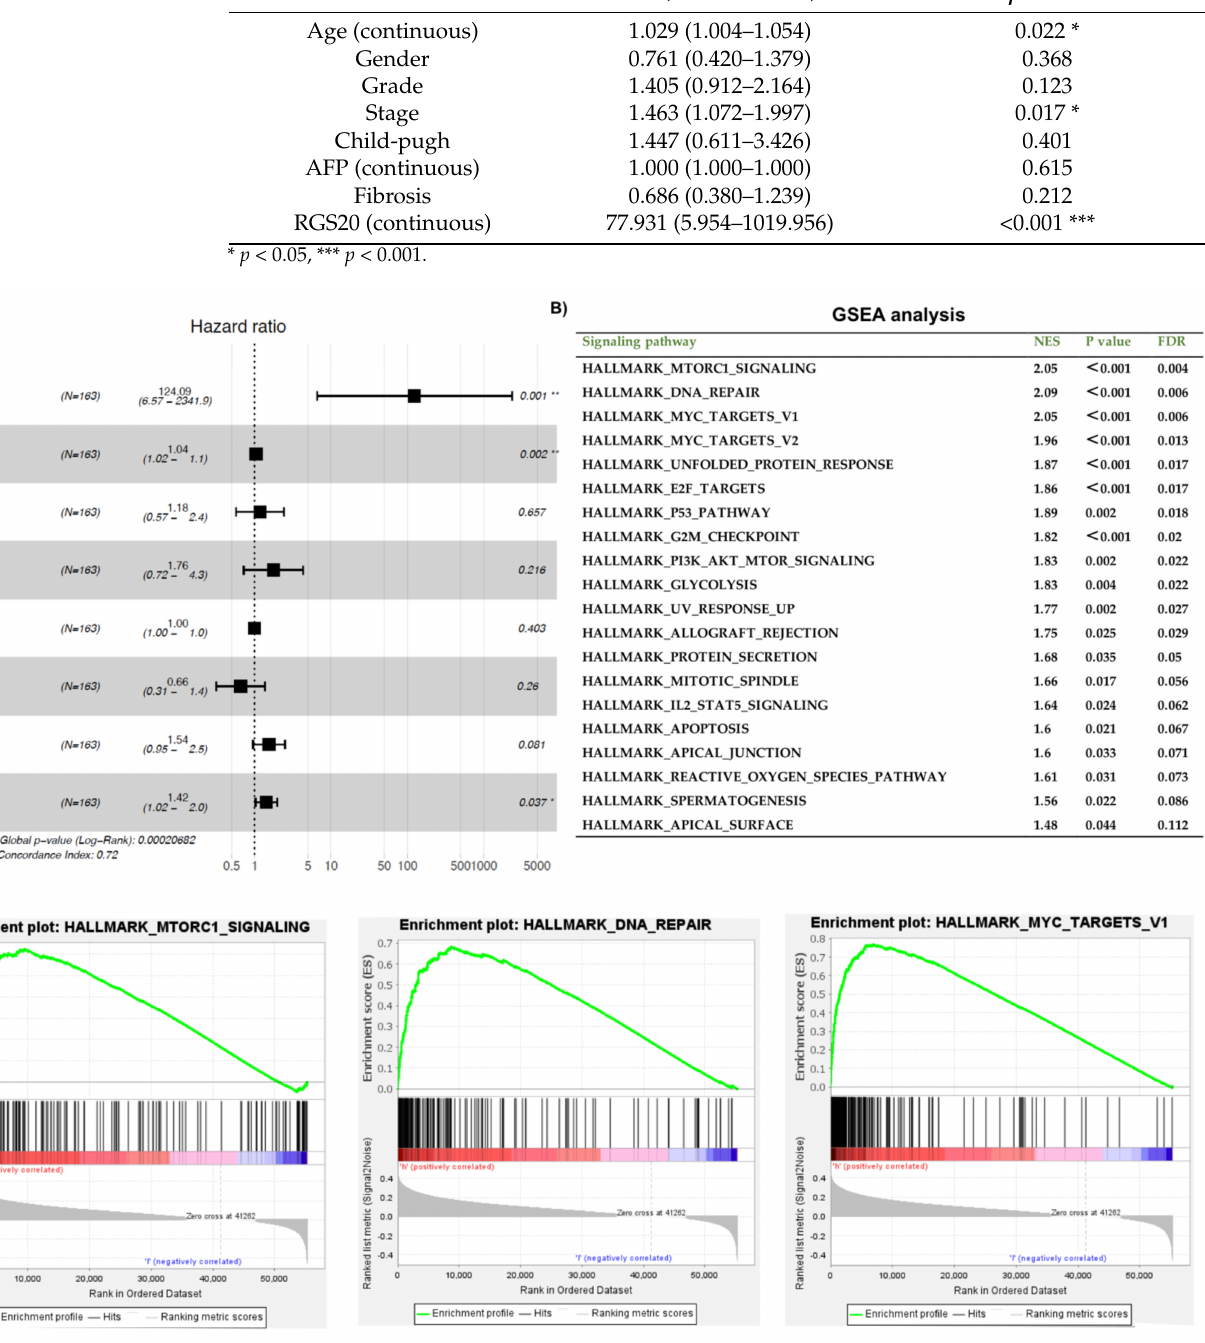
Figure 3. Multivariable Cox regression and GSEA enrichment analysis. ( A ) Multivariable Cox survival model including RGS20 and clinical features. The hazard ratio values are represented by squares.